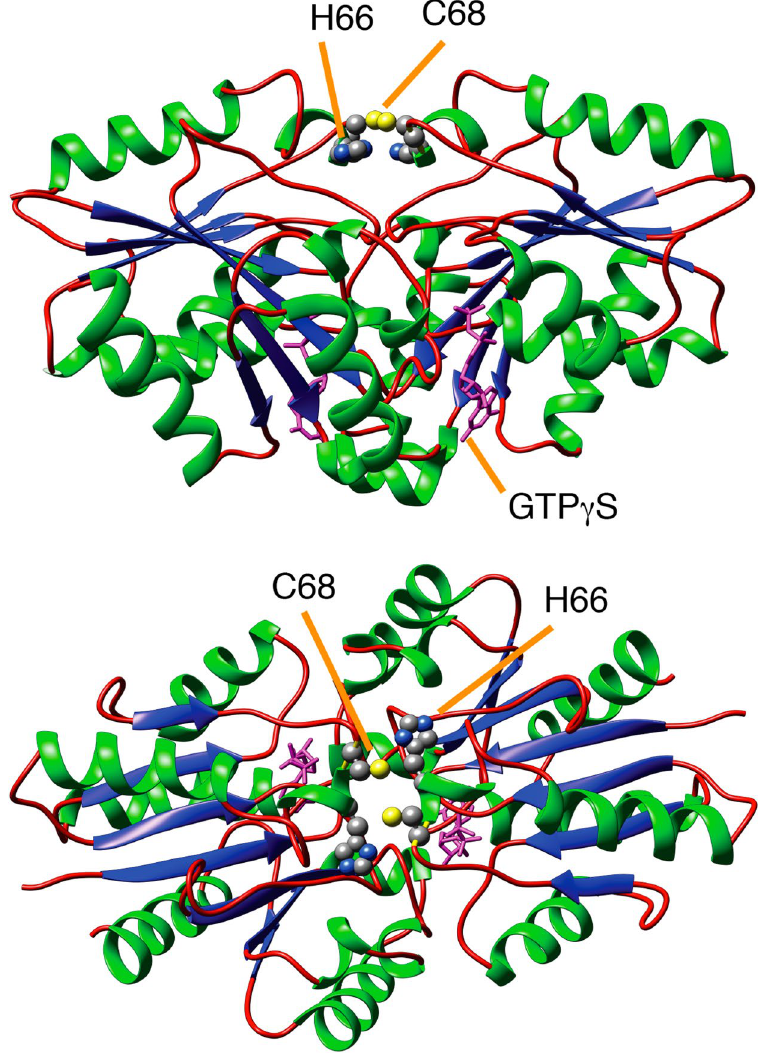
Figure 1. Cartoon representation of the previously reported model structure of Sp UreG in the fully folded functional state 25 . Metal binding residues His 66 and Cys 68 are indicated, as well as the GTP γ S substrate